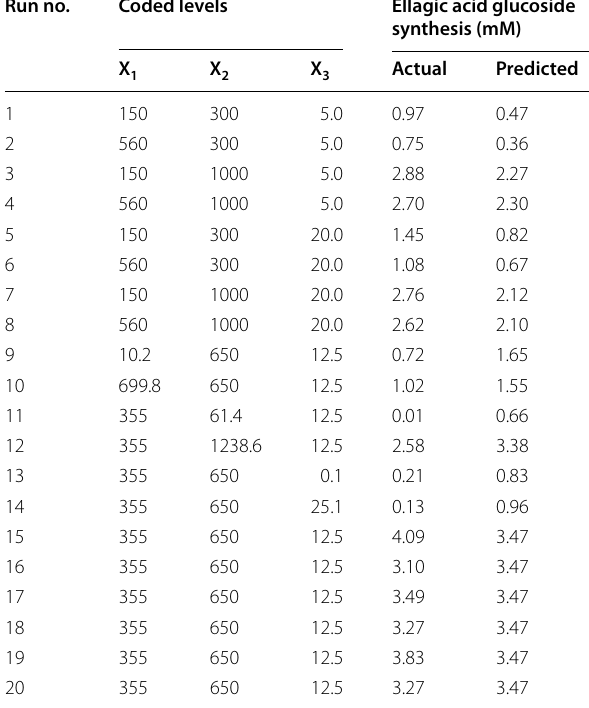
Table 1 Central composite design matrix for the experiment and predicted responses for the synthesis of ellagic